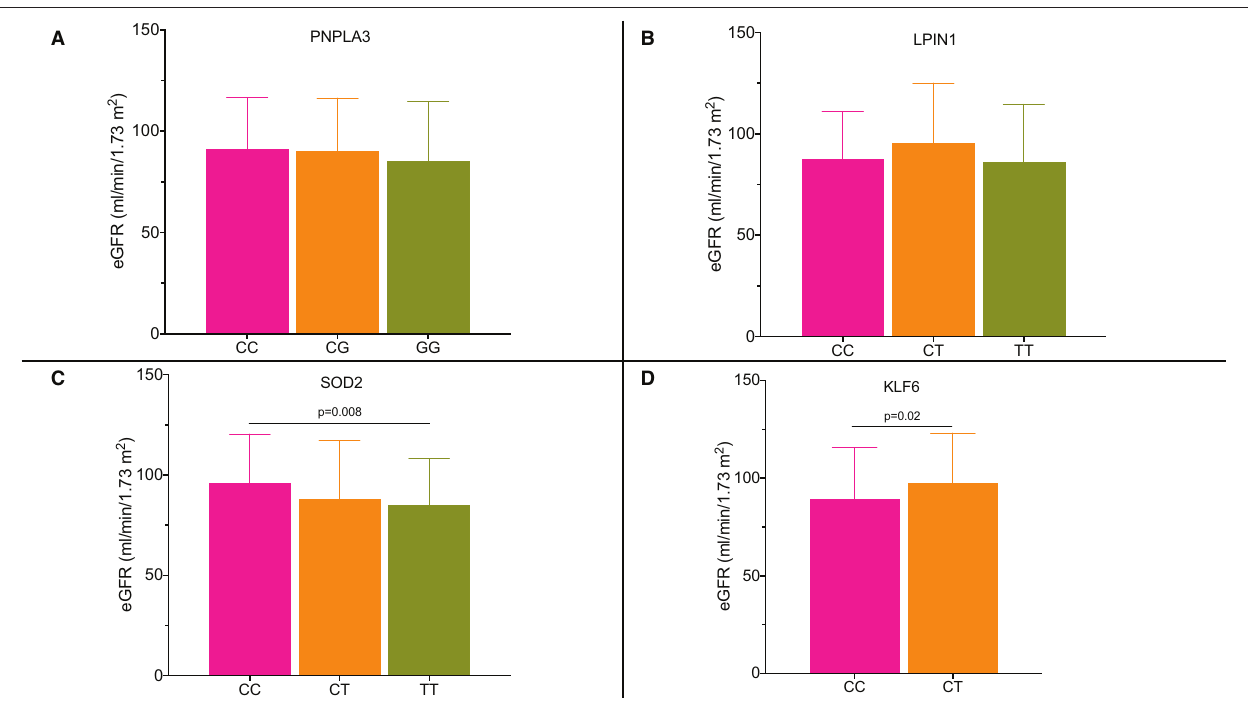
We analyzed their genotypes and found that all the patients except for four had GG genotype for PNPLA3 rs738409 SNP, whereas all the patients except for one had at least one allele risk for LPIN1 rs13412852 SNP. All the patients with cirrhosis had at least one risk allele for SOD2 rs4880 SNP too. Patients included in the non-diabetic group did not show different stiffness values by the genotypes for all the studied SNPs (data not